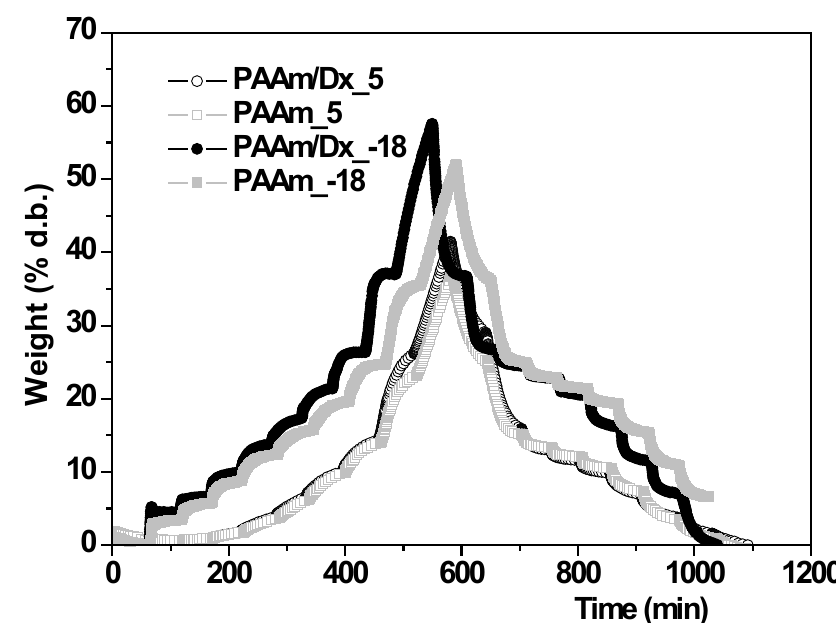
a The onset temperature of the decomposition. b Thermal degradation peak temperatures of the decomposition. c Mass loss in every stage. d Mass remained after the decomposition process.